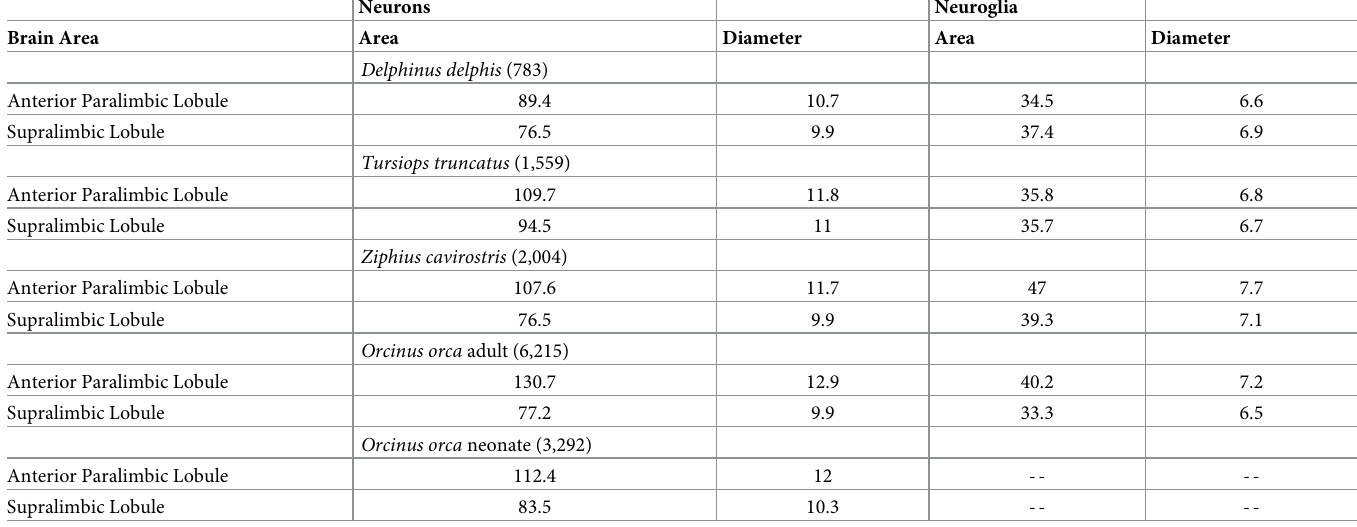
Table 1. A trend for larger paralimbic neurons in larger brains.